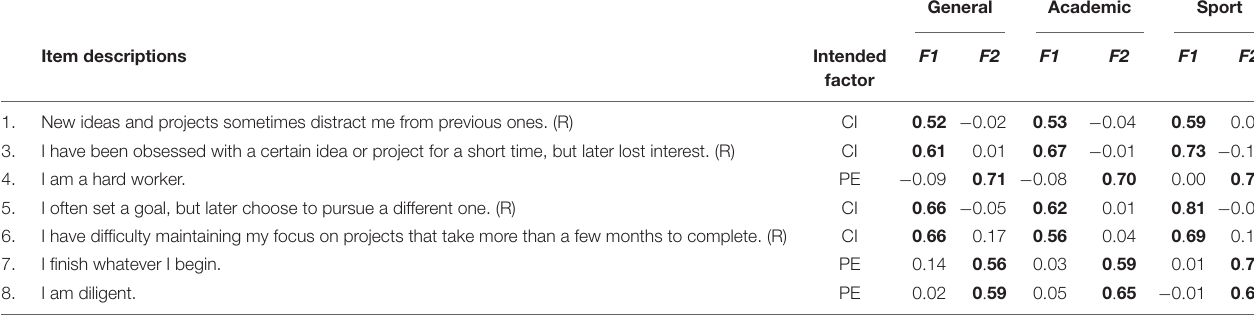
TABLE 2 | Pattern coefficients for principal axes factor analyses with direct oblimin rotations of the 7-item general, academic, and sport versions of the Grit-S.